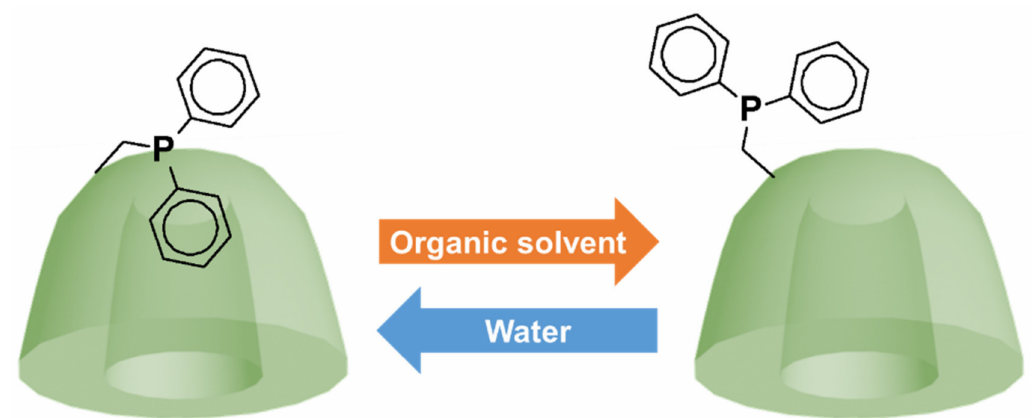
Figure 16. Permethylated β -CD phosphine conformation as a function of